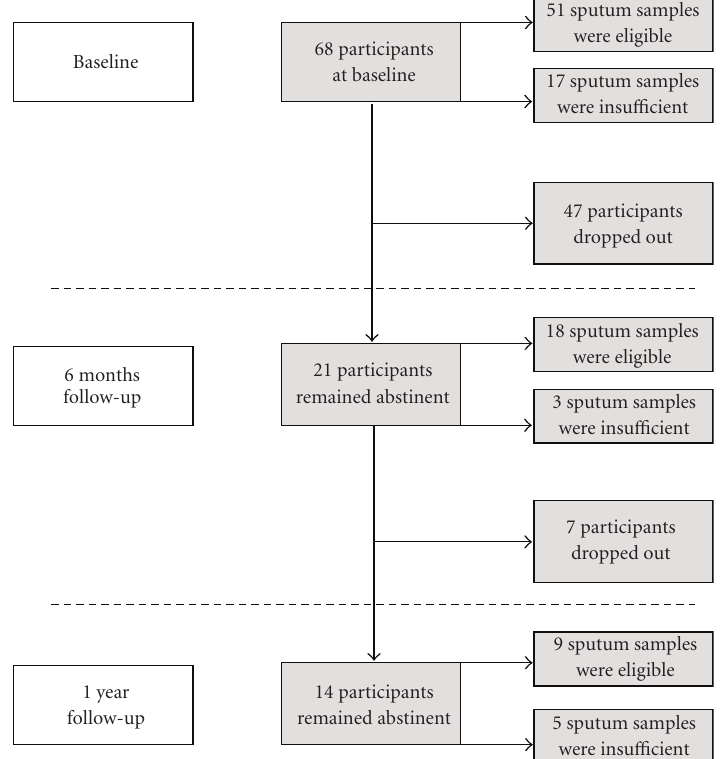
Figure 1: Flowchart of participation, smoking cessation and sputum